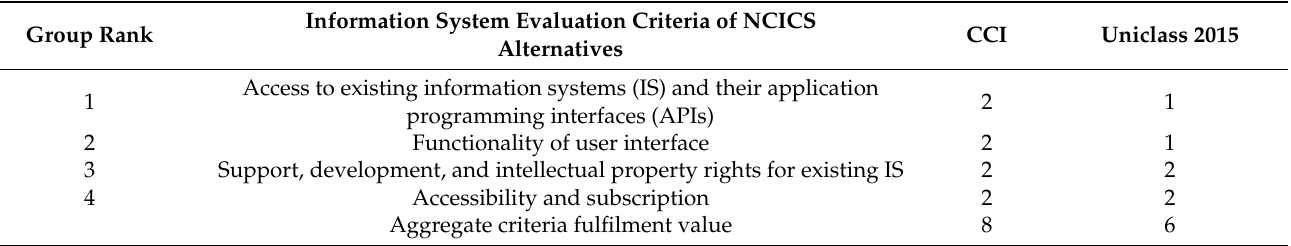
Table 9. Information system evaluation criteria of NCICS alternatives, their ranking in order of importance, and compliance with alternatives.